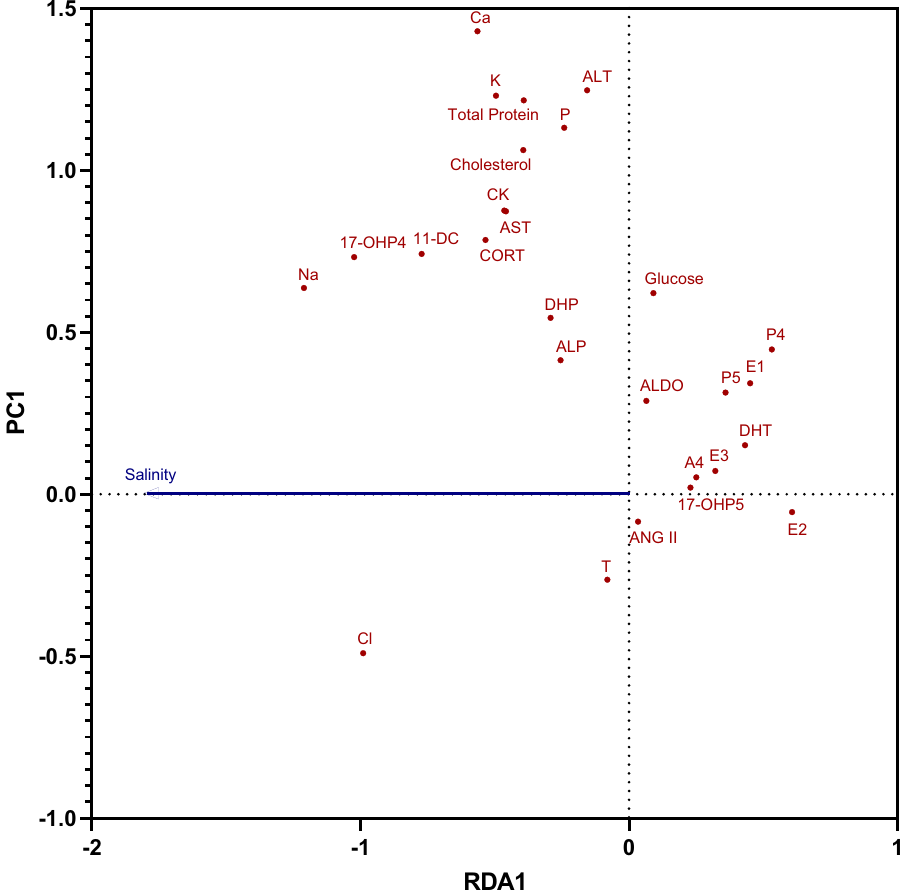
Figure 3. Partial redundancy analysis using environmental salinity in which American alligators ( Alligator mississippiensis ) were found as a predictor and holding total length, sex, and month constant. Abbreviated are angiotensin II (ANG II), aldosterone (ALDO), 11-deoxycortisol (11-DC), corticosterone (CORT), pregnenolone (P5), 17α-hydroxypregnenolone (17-OHP5), progesterone (P4), 17α-hydroxyprogesterone (17-OHP4), 17α,20β- dihydroxypregnenone (DHP), androstenedione (A4), 5α-dihydrotestosterone (DHT), testosterone (T), estrone (E1), 17β-estradiol (E2), estriol (E3), sodium (Na), chloride (Cl), potassium (K), calcium (Ca), phosphorus (P), alkaline phosphatase (ALP), aspartate aminotransferase (AST), and alanine aminotransferase